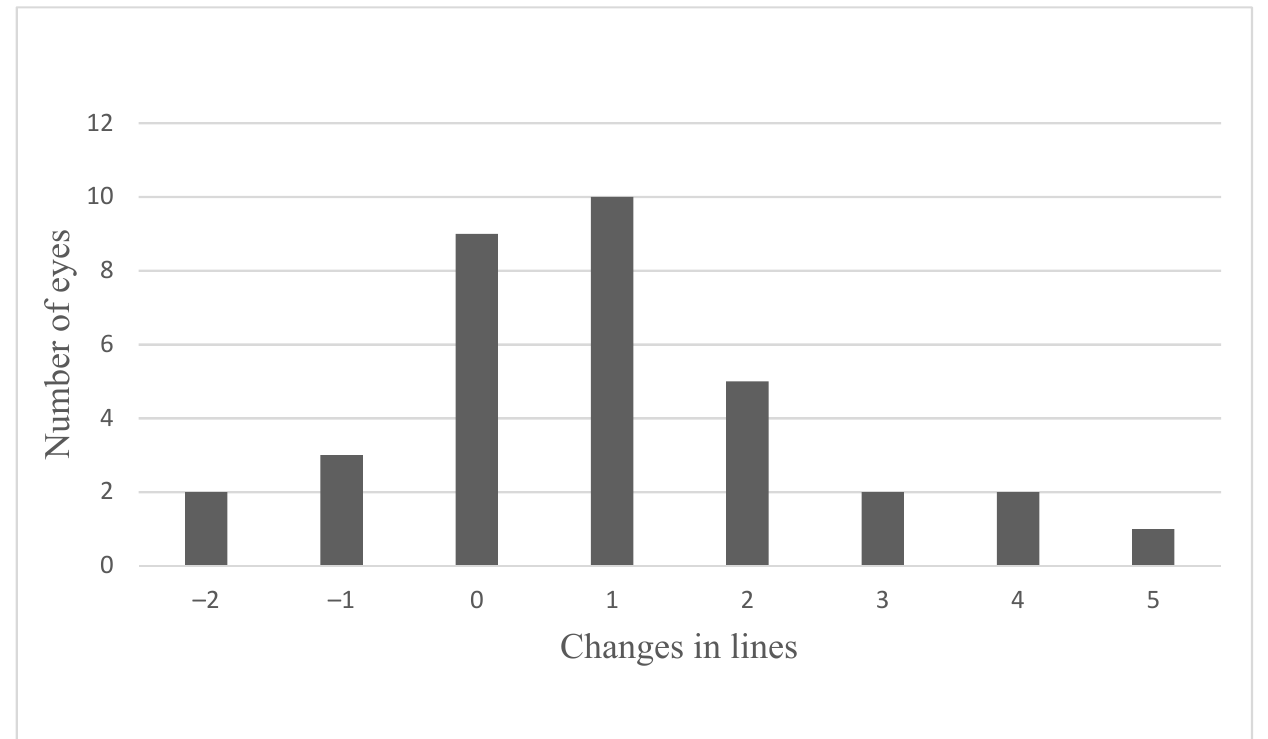
Figure 5. Maximal change of visual acuity in lines following the intravitreal injection of a FAc implant.